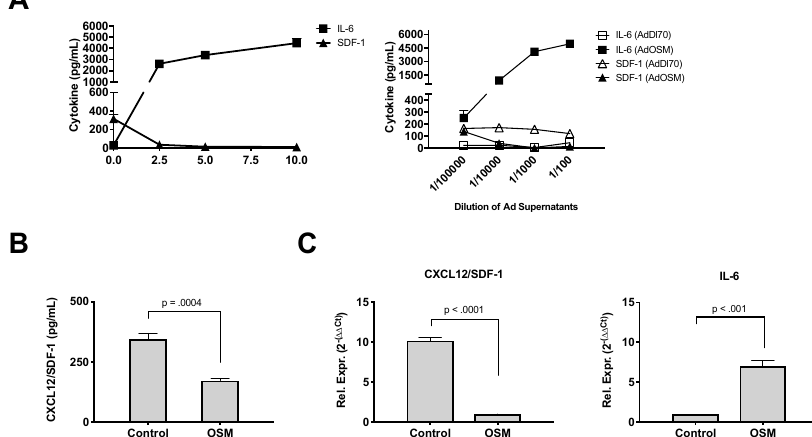
Figure 5. OSM downregulates expression of CXCL12/SDF-1 in mouse lung fibroblasts. BALB/c-derived mouse lung fibroblasts (MLF) were stimulated for 24 h (in triplicate) with increasing dosing of recombinant murine OSM (ng/mL) and supernatants analyzed by ELISA for CXCL12/SDF-1 or IL-6 ( A, left panel ). In ( A right panel ), MLF cells were incubated with dilutions of supernatants from AdDl70 (control)- or AdOSM-infected A549 cells (from 10 − 5 to 10 − 2 ), for 24 h, and MLF supernatants analyzed by ELISA for CXCL12/SDF-1 and IL-6. In ( B ), MLF cells derived from C57Bl/6 mice were stimulated for 24 h with recombinant OSM (10 ng/mL) and secreted CXCL12/SDF-1 protein was measured by ELISA. ( C ) CXCL12/SDF-1 and IL-6 mRNA expression in C57Bl/6-derived MLF cells was measured by quantitative PCR. Rel. Expr.: Relative expression (Relative to 18S RNA). Data represent one of at least three separate experiments. Data is shown as the mean +/ − SD ( n = 4